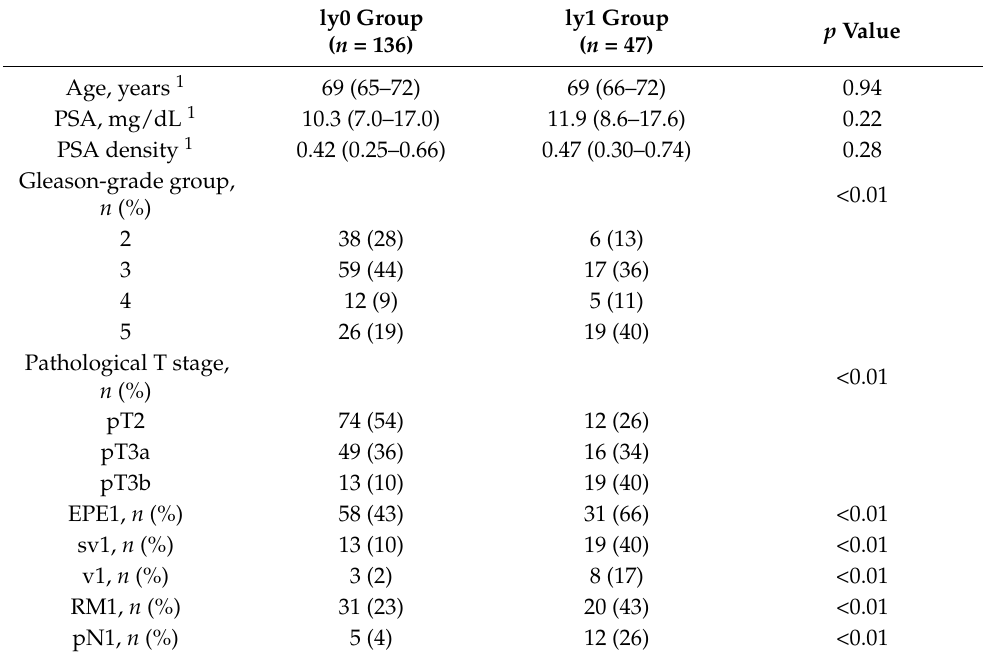
Table 2. Comparison of patient demographics and histopathological findings of resected specimens between the ly0 and ly1